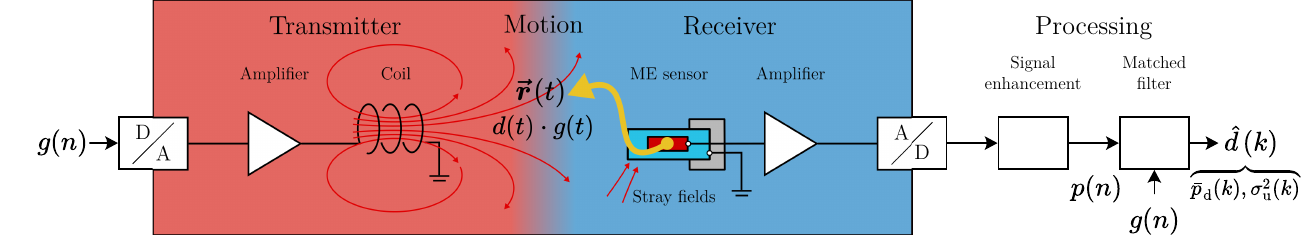
Figure 1. Magnetic motion sensing system